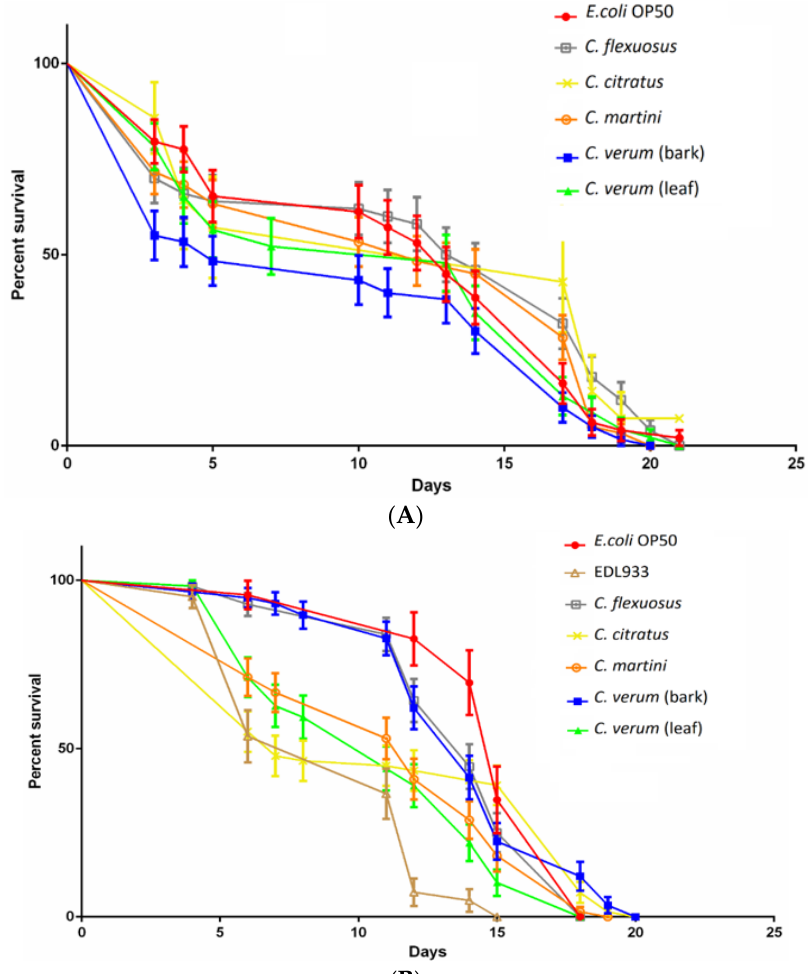
Figure 5. ( A ) Effect of EOs on survival of C. elegans infected with E. coli OP 50. Nematodes infected with OP 50 without oil were used as control. ( B ) Effect of EOs on the survival of C. elegans infected with EDL933. Nematodes infected with E. coli OP 50 and EDL933 in the absence of EOs were used as controls. The experiment was performed three times.